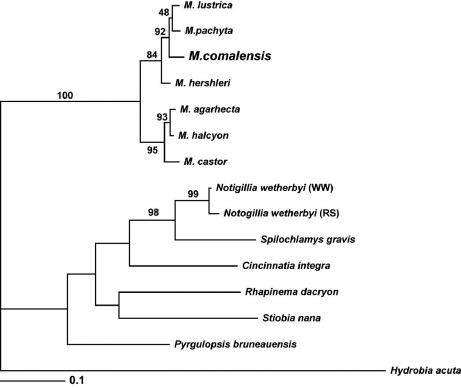
Bayesian tree based on the COI dataset. Posterior probabilities for each node within the Marstonia clade are shown for the reader’s interest; only those >95% are considered significant.